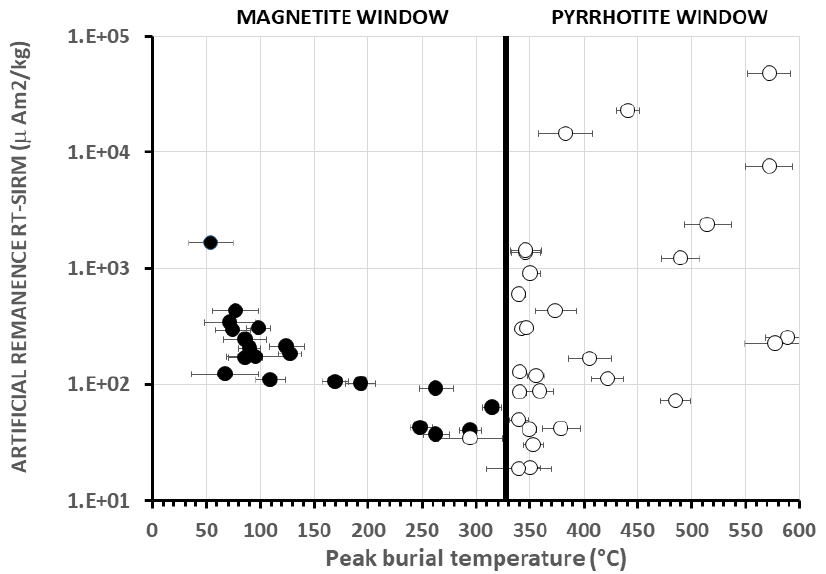
Figure 2. Artificial remanence (RT-SIRM) of shales from the Pyrenees and Taiwan mountain belt. Data from Aubourg et al. [19]. The black circles correspond to shales in which magnetite was the main ferromagnetic mineral. For the white circles, pyrrhotite was the main mineral. The peak burial temperature ( T B ) of shales was derived from vitrinite analysis and from Raman spectroscopy of carboniferous material at 50 °C to ~330 °C. Pyrrhotite >1 µm was formed at the expense of magnetite and pyrite. Redrawn from Aubourg et al. [19].